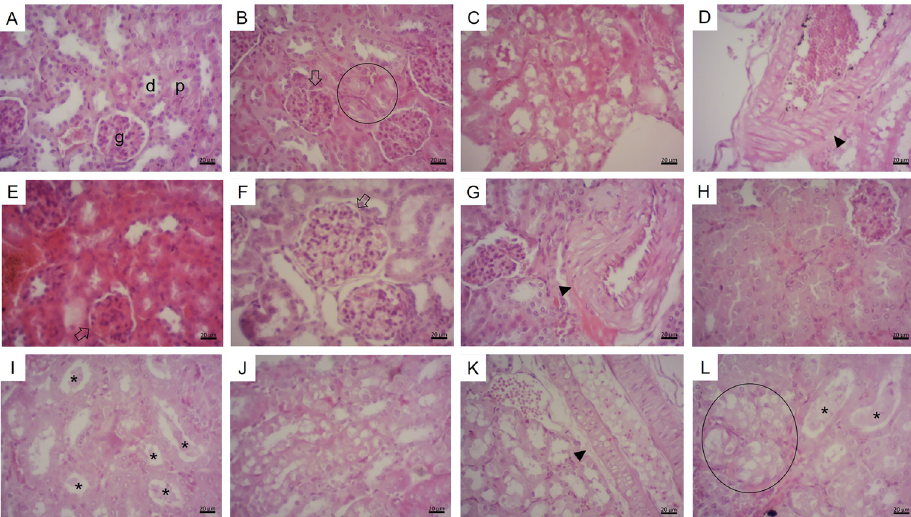
Figure 3. H&E kidney histology. A , Female - negative control group: normal renal parenchyma, glomerulus (g), proximal tubule (p), and distal tubule (d). B , Female - MeHg group: hypertrophied glomerulus (arrow), swollen tubules (circle). C , Male - MeHg group: area with cells in vacuolar degeneration. D , Male - MeHg group: vessel with hyaline degeneration in the media layer (arrowhead). E , Male - PRL 25 group: hypertrophied glomerulus (arrow). F , Female - PRL 25 group: hypertrophied glomerulus (arrow). G , Female - PRL 250 group: vessel with hyaline degeneration in the media layer (arrowhead). H , Male - PRL 250 group: swollen tubules. I , Male - MeHg + PRL 25 group: desquamation of necrotic cells in the tubules (asterisks). J , Male - MeHg + PRL 25 group: area with vacuolar degeneration cells. K , Female - MeHg + PRL 250 group: vessel with hyaline degeneration in the media layer (arrowhead). L , Male - MeHg + PRL 250 group: peeling of necrotic cells in the tubules (asterisks), area with cells in vacuolar degeneration (circle). Scale bar: 20 m m. MeHg: methylmercury; PRL 25 and PRL 250: 25 and 250 m g/kg prolactin, respectively, every 12 h.